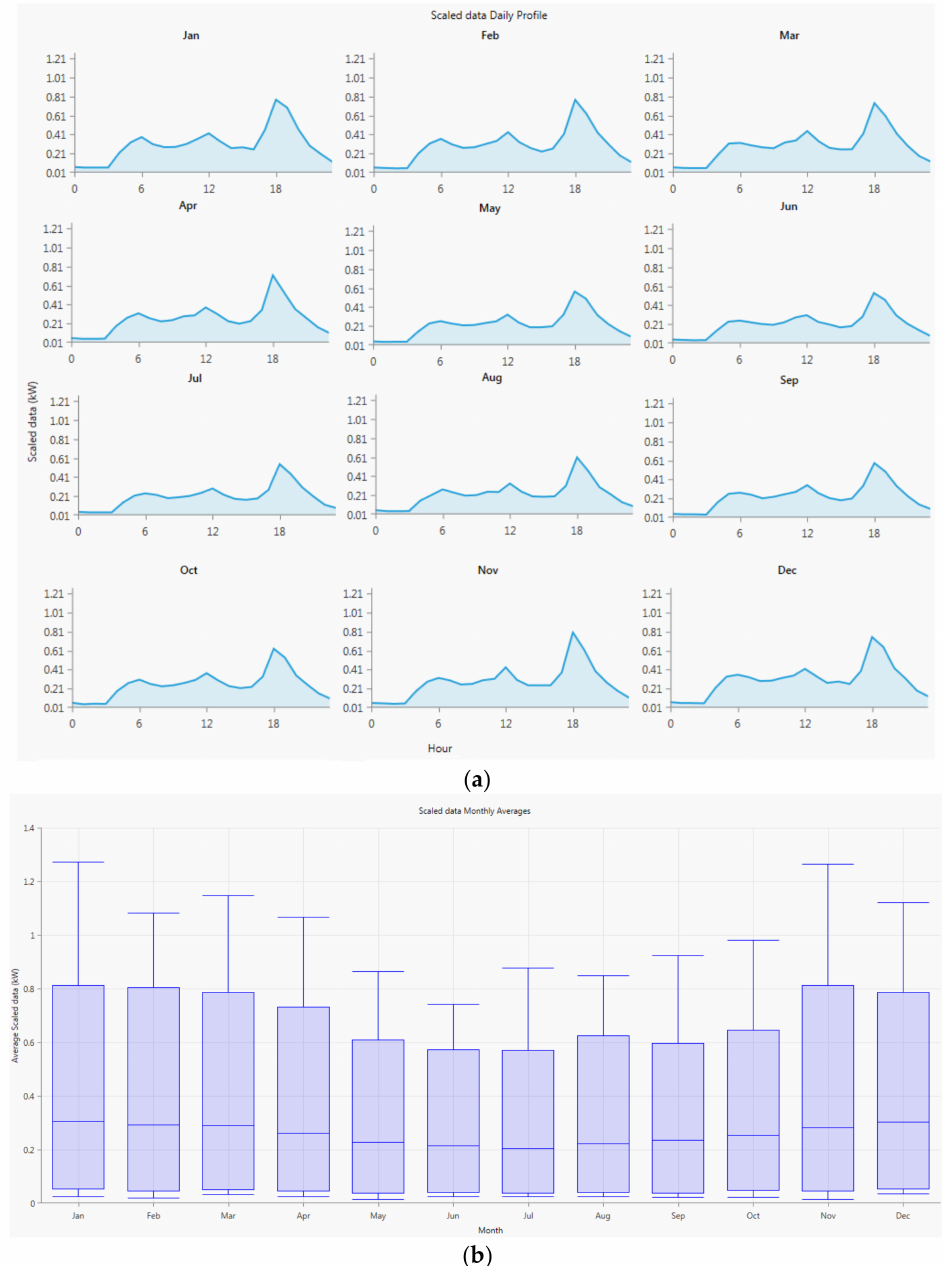
Figure 10. ( a ) Scaled daily load profile; and ( b ) Scaled Load averages (KW) for each month (January–December) of the year 2017, considered for analysis using